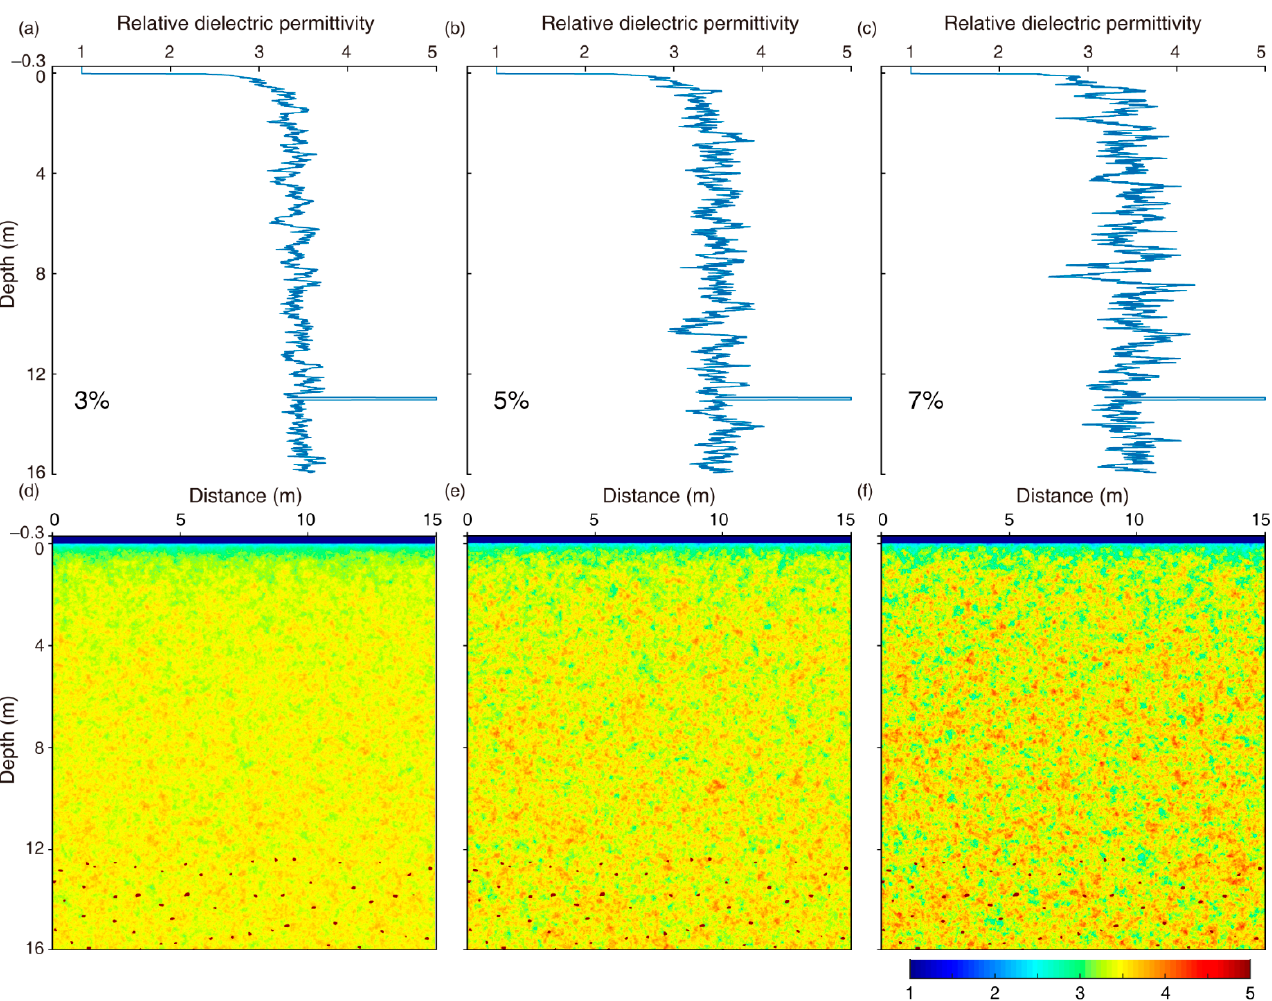
Figure 5. Exponential ACF models with different RMS perturbations. ( a – c ) Fluctuation of the 1D probe along the center of the 2D model. ( d – f ) 2D relative dielectric permittivity models with three perturbations. The RMS perturbation were ( a , d ) 3%, ( b , e ) 5%, and ( c , f ) 7%, respectively. The correlation distance is 10 cm.